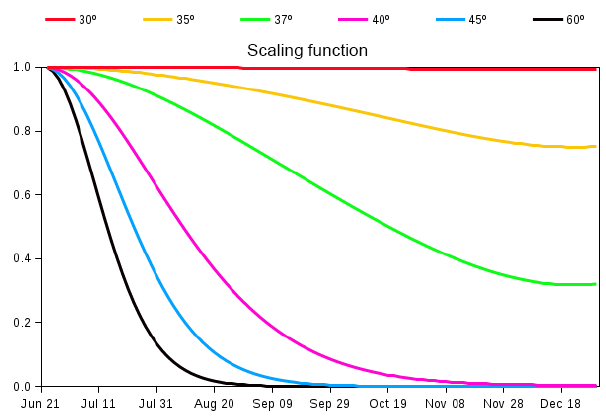
Figure 2. Latitude dependence factor ( (cid:48) ) (Eq. 8) for reducing allo- cation fraction to leaves after summer